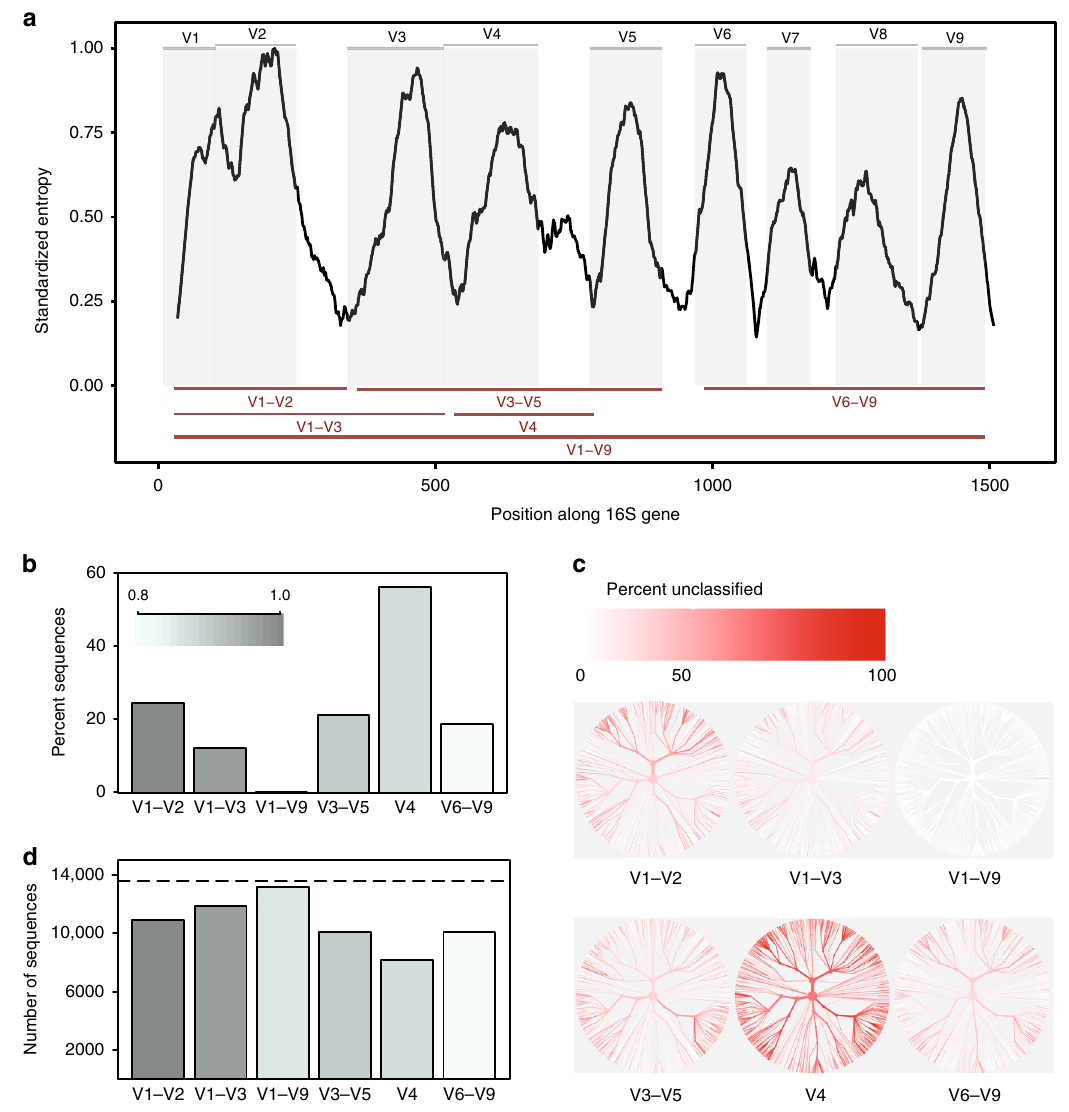
Fig. 1 In-silico comparison of 16S rRNA variable regions. a Shannon entropy across the 16S gene based on the alignment of a single representative sequence for each known species present in the Greengenes database. Sequences were aligned against a single reference 16S gene for Escherichia coli K-12 MG1655 (NCBI Gene ID 947777). Gray panels depict variable regions de fi ned by commonly used primer-binding sites (Supplementary Table 1). Variable regions considered in this study are shown as red lines (bottom). b Proportion of sequences for each variable region that could not be identi fi ed to species level when classifying each sequence against the reference database from which it was derived at a con fi dence threshold of 80% (RDP classi fi er). c Trees based on taxonomy of sequences present in the in-silico database. The same tree is provided for each variable region. The color of each branch re fl ects the proportion of sequences within each clade that could not be identi fi ed to species level. d The number of OTUs created when clustering sequences for each variable region at 99% sequence similarity. Dashed line indicates the number of unique sequences (>1% different) in the original database. Source data